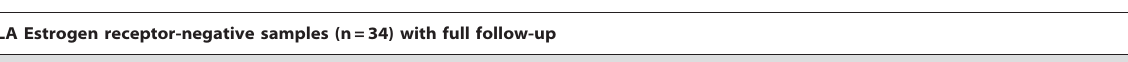
Table 4. Multivariate Cox proportional hazards model with stromal-laminin for UPPSALA estrogen receptor-negative samples.